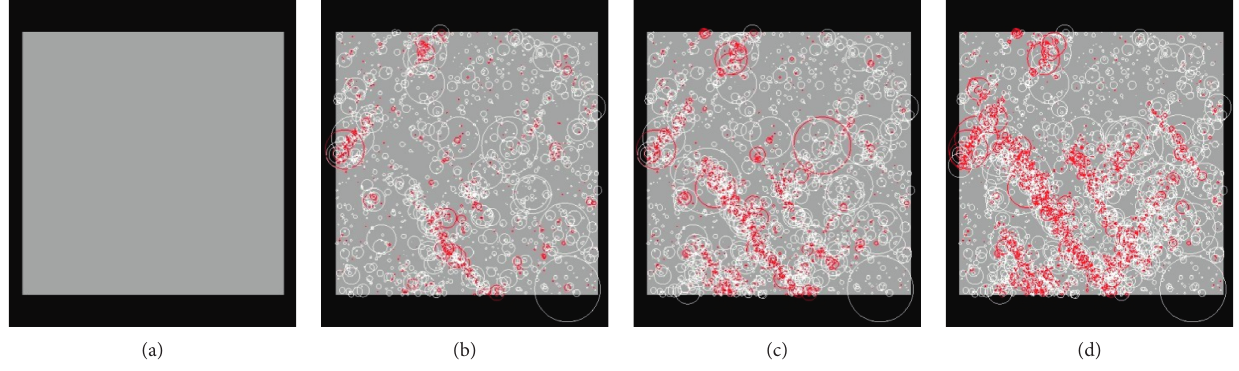
Figure 11: Acoustic emission of rock mass at ratio of height to diameter of